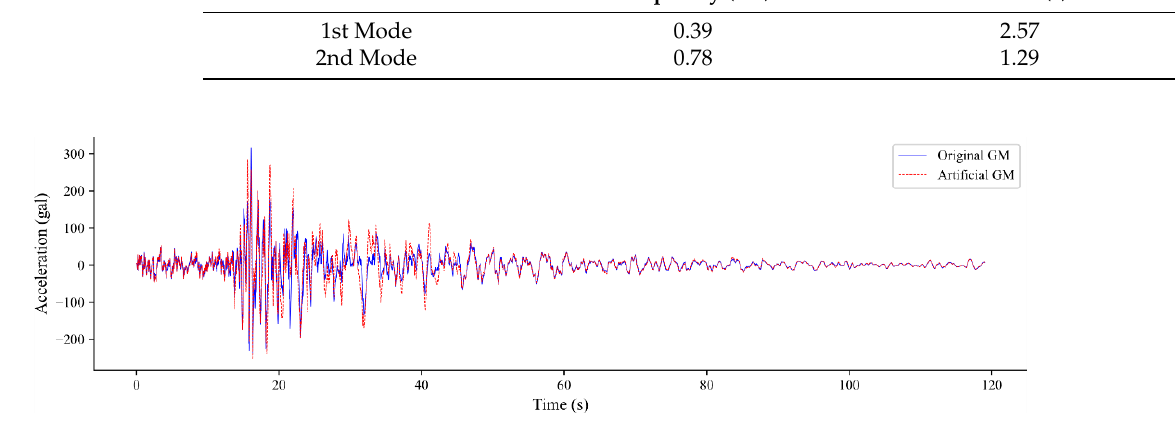
Figure 8. Acceleration time series of original signal and artificial signal.